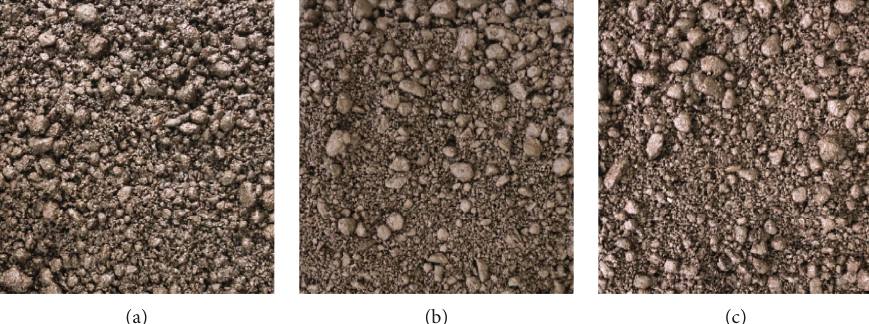
Figure 8: Mixing state of CRME with 3% of additional water content. (a) CRME with SP. (b) Reference CRME. (c) CRME with DN500.